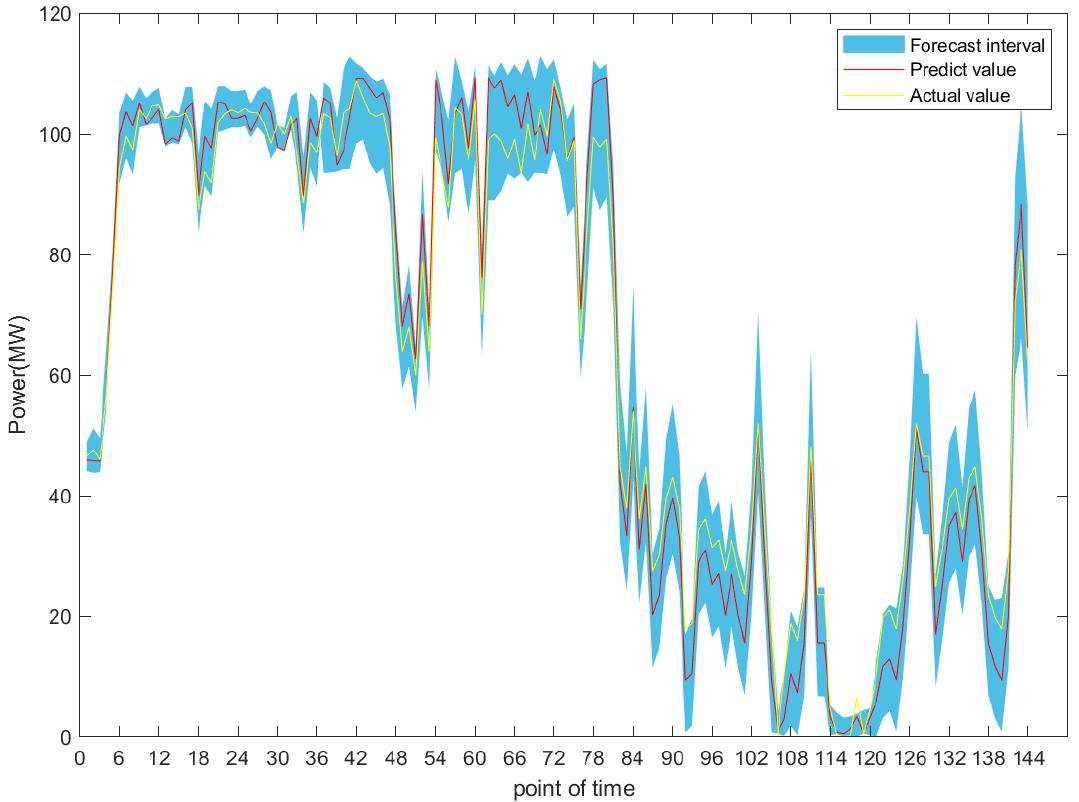
Figure 6. Forecast results of wind power interval at 36 time points in the future.